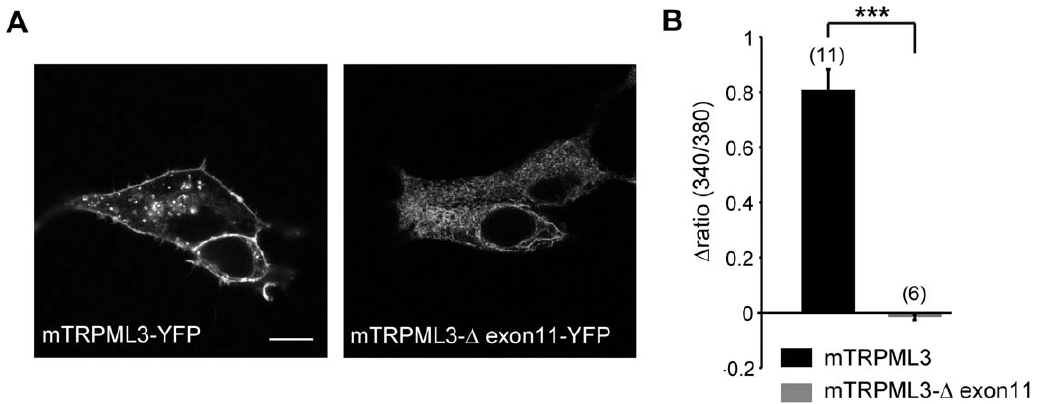
Figure 3. Molecular and functional assessment of mutant TRPML3( D exon11) channels. A, Shown are representative cells expressing the respective murine (m) constructs of wild-type TRPML3 or mutant TRPML3( D exon11), C-terminally fused to yellow fluorescent protein, 24 h after transfection. Scale bar=10 m m. B, Ca 2 + imaging results showing relative [Ca 2 + ] i increases after application of TRPML3 activator SN-2 in HEK293 cells expressing wild-type TRPML3 or mutant TRPML3( D exon11). Shown are mean values 6 SEM (numbers in parentheses are the numbers of independent experiments with 10–20 cells each). Statistical comparisons of means were made using Student’s t test (unpaired); ***p , 0.0001.